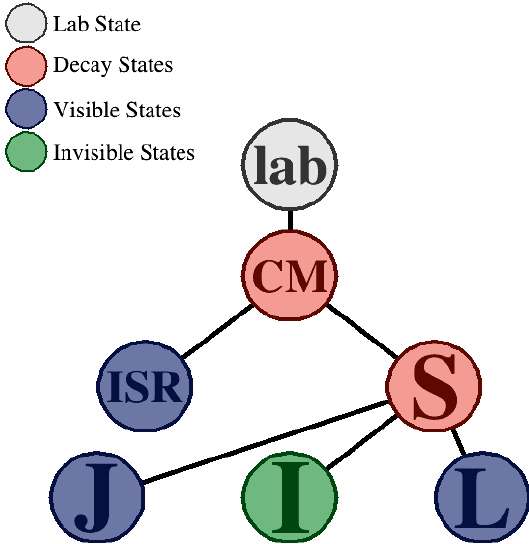
Figure 3. The general compressed decay tree used in the RJR technique. CM denotes the center- of-mass frame giving rise to a back-to-back ISR and (S) systems. The (S) system decays to visible jets (J) and invisible (I) states and to leptons